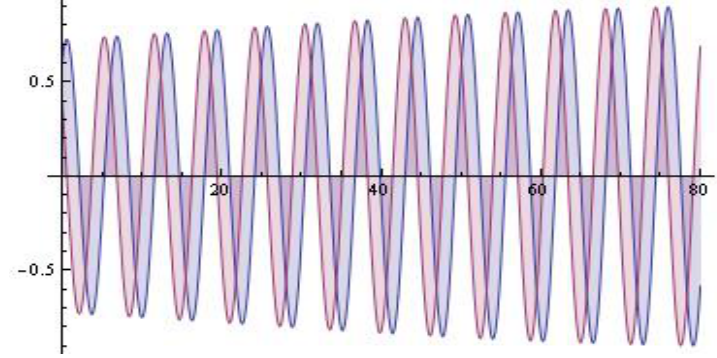
Figure 2. The system solutions ( (cid:101) = 0.006; n = 5).